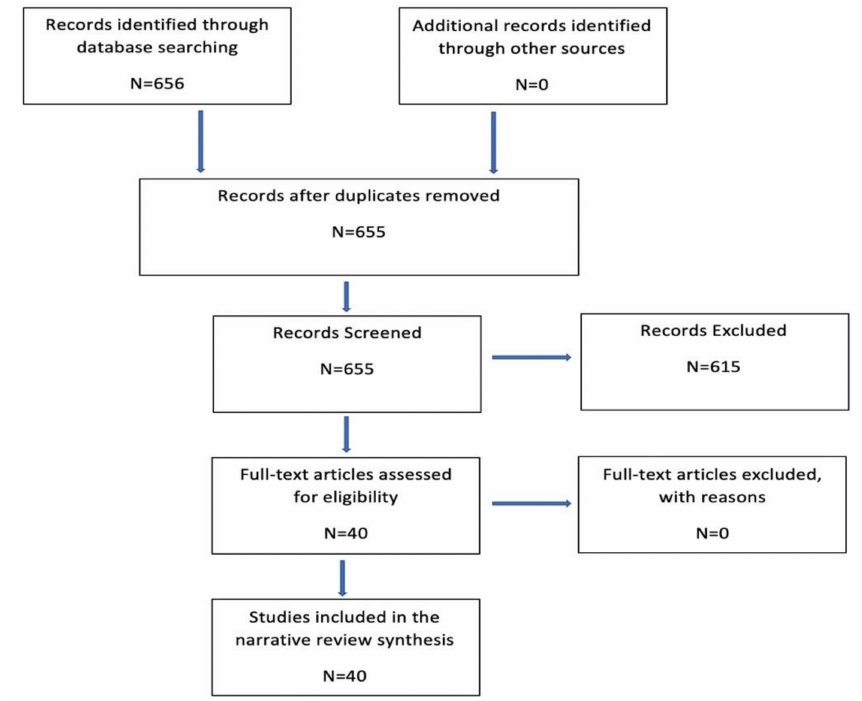
Figure 1. Flow diagram of search